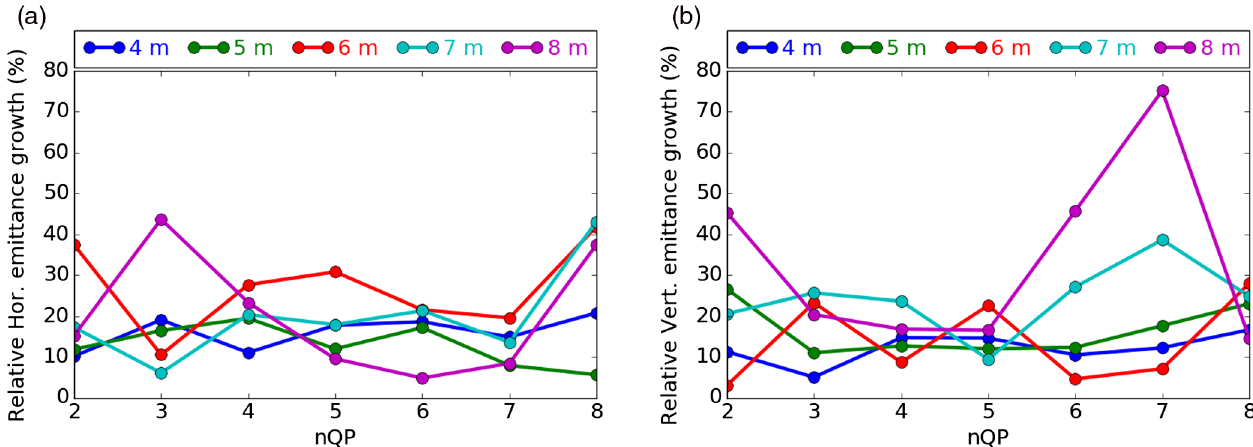
FIG. 7. Relative emittance growth [(a) horizontal and (b) vertical] as a function of the number of permanent quadrupoles and of the transfer line total